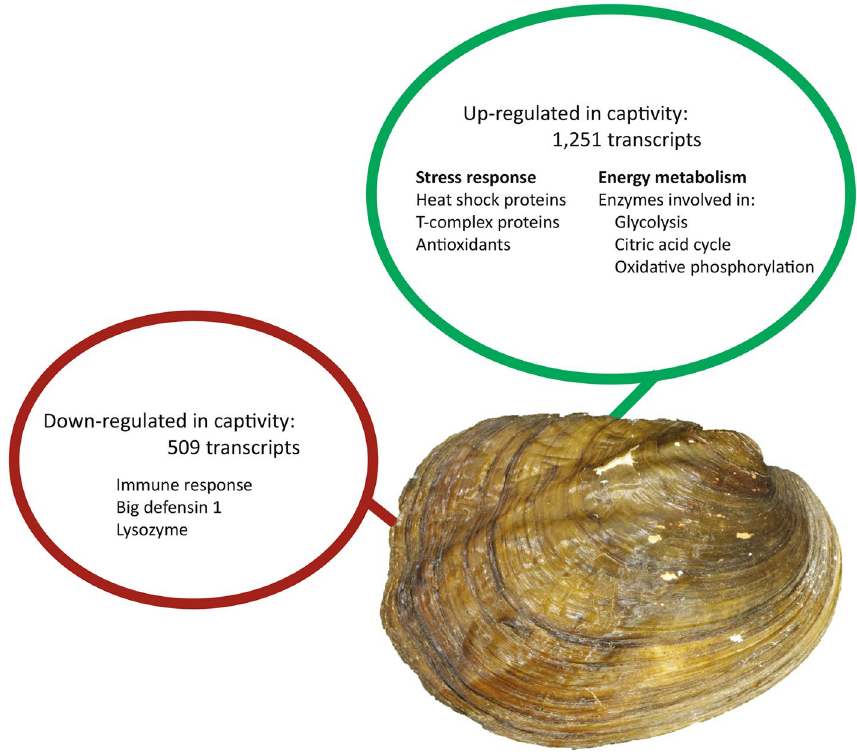
Figure 1. Overview of differential gene expression in Amblema plicata held in captivity for 11